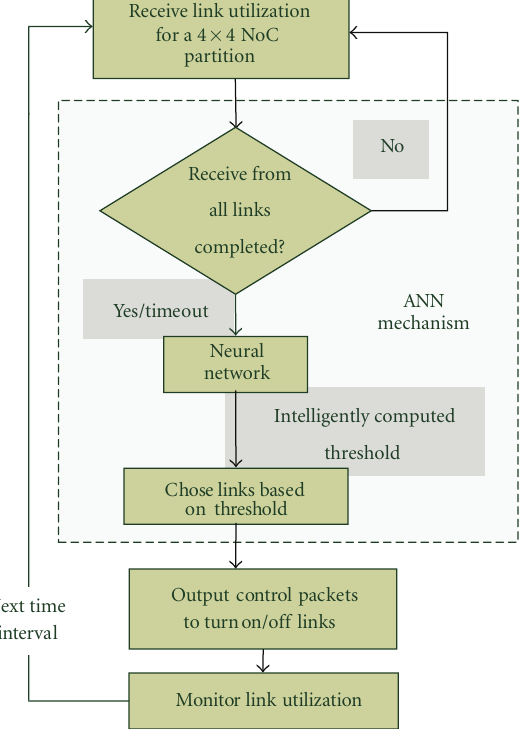
Figure 5: Main steps of a 4 × 4 ANN predictor.